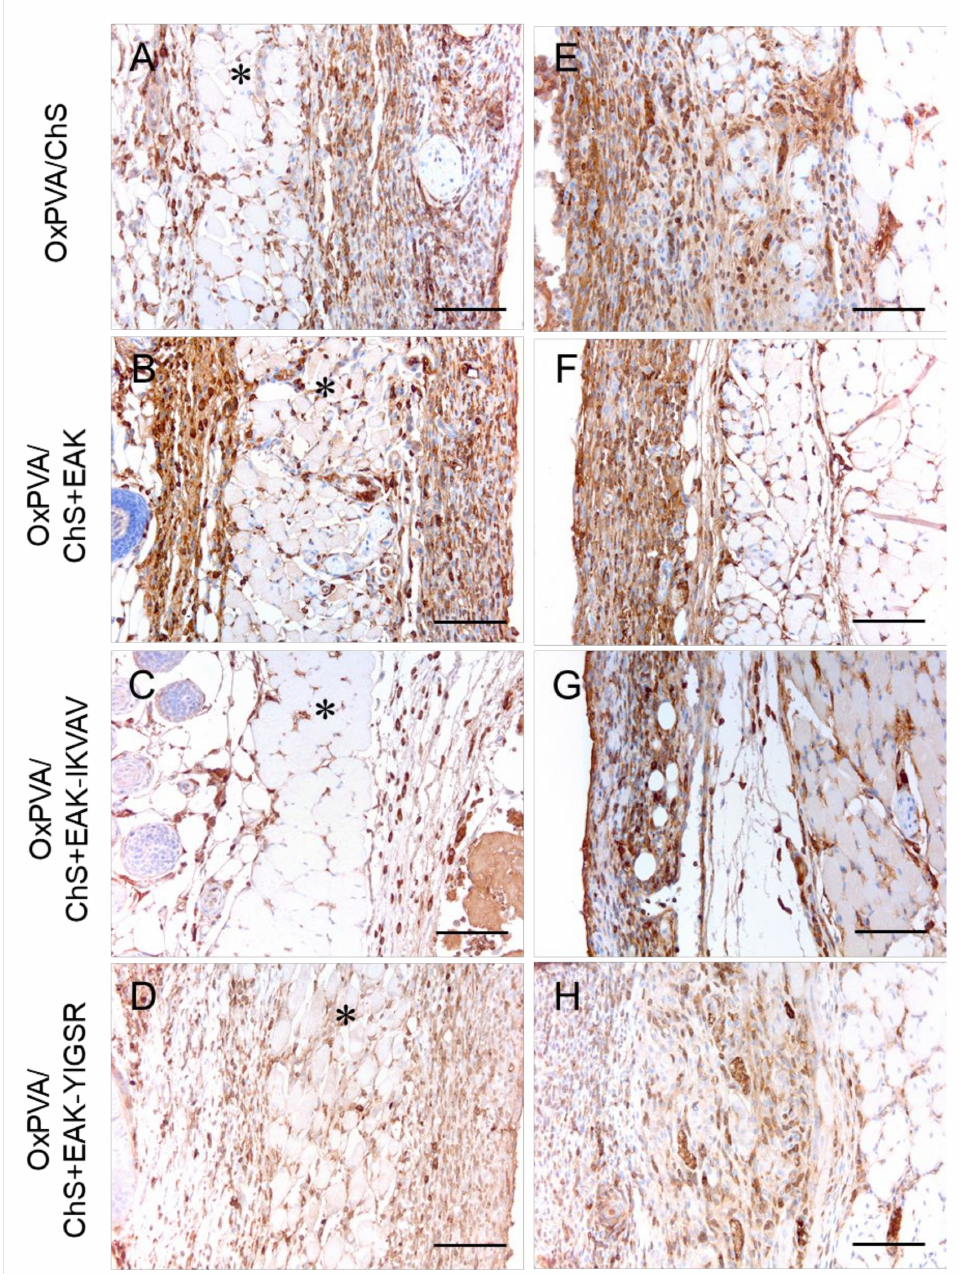
Figure 7. Immunolocalization of the lymphocyte T (CD3+ cells) infiltration at the superficial ( A – D ) and deep ( E – H ) aspects of the grafts after subcutaneous implantation of OxPVA/ChS-based scaffolds for 14 days. Scale bar: 100 µ m. (*: the panniculus carnosus within the host subcutaneous